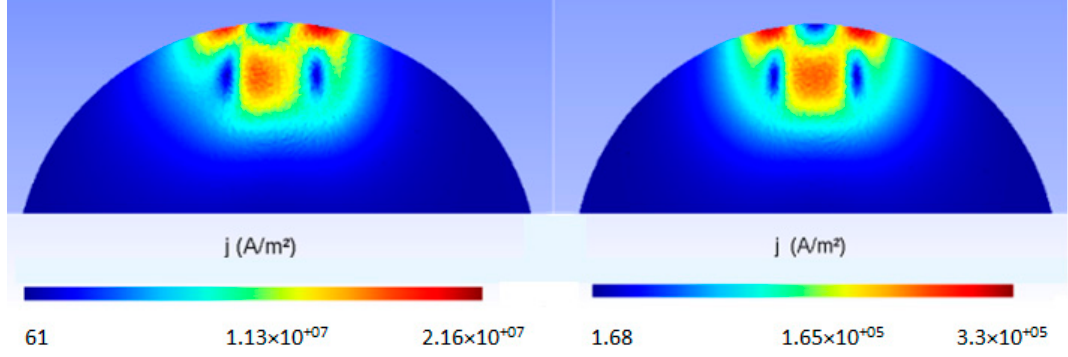
Figure 11. Module of the induced current densities for Wr – = 34 and 0.5 rad/s, respectively.